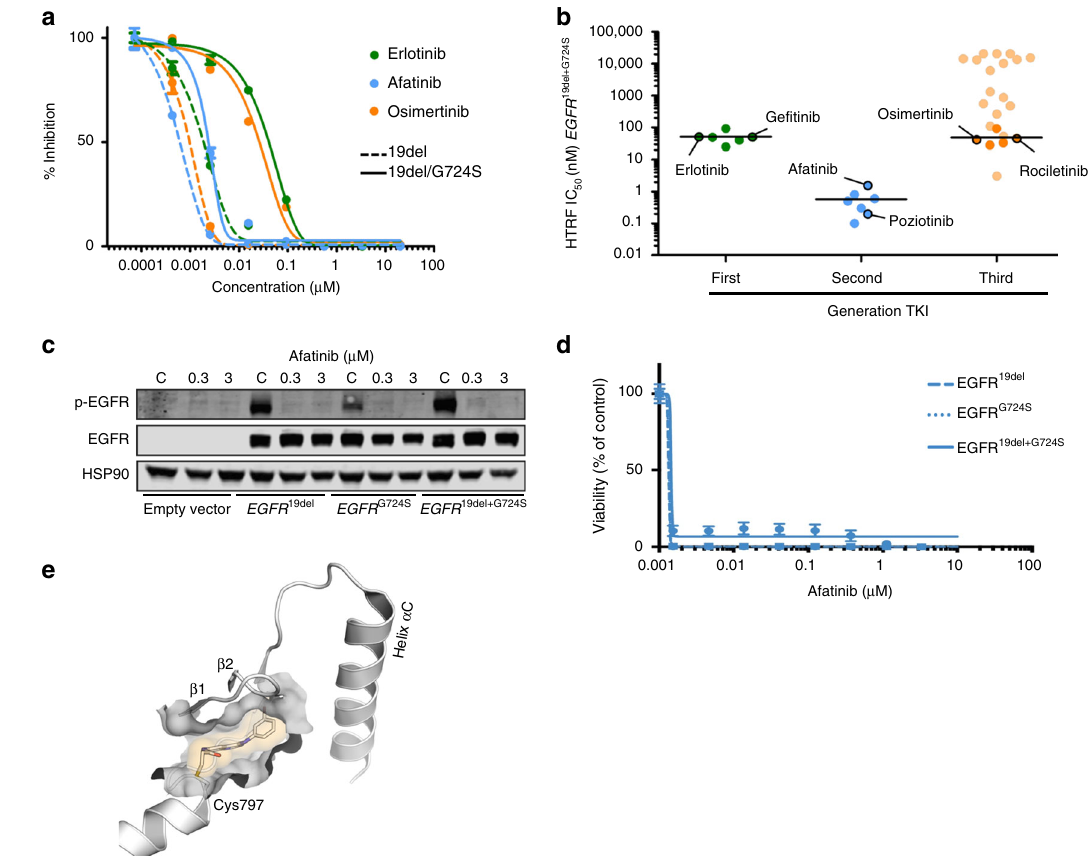
Fig. 4 Biochemical pro fi ling of EGFR G724S . a Homogeneous time-resolved fl uorescence (HTRF) is used for IC 50 -determination for EGFR 19del and EGFR 19del + G724S with representative inhibitors. Representative dose – response curves of a single measurement in duplicates are shown. b Comparison of biochemical IC 50 -values with HTRF for the three generations of EGFR TKIs against EGFR 19del + G724S . Values are the mean of three independent measurements in duplicates. c Immunoblotting results of NIH-3T3 cells (empty vector, EGFR 19del , EGFR G724S or EGFR 19del + G724S ) showing phospho-EGFR and total EGFR under afatinib treatment (24 h). HSP90 was used as loading control ( n = 3). d Dose – response measurement of Ba/F3 cells expressing EGFR 19del , EGFR G724S , or EGFR 19del + G724S treated for 72 h with afatinib. Experiments were accomplished for at least three times. e Structure of exon 20 mutant EGFR , bound to 4-anilinoquinazoline based TKI PD168393, is